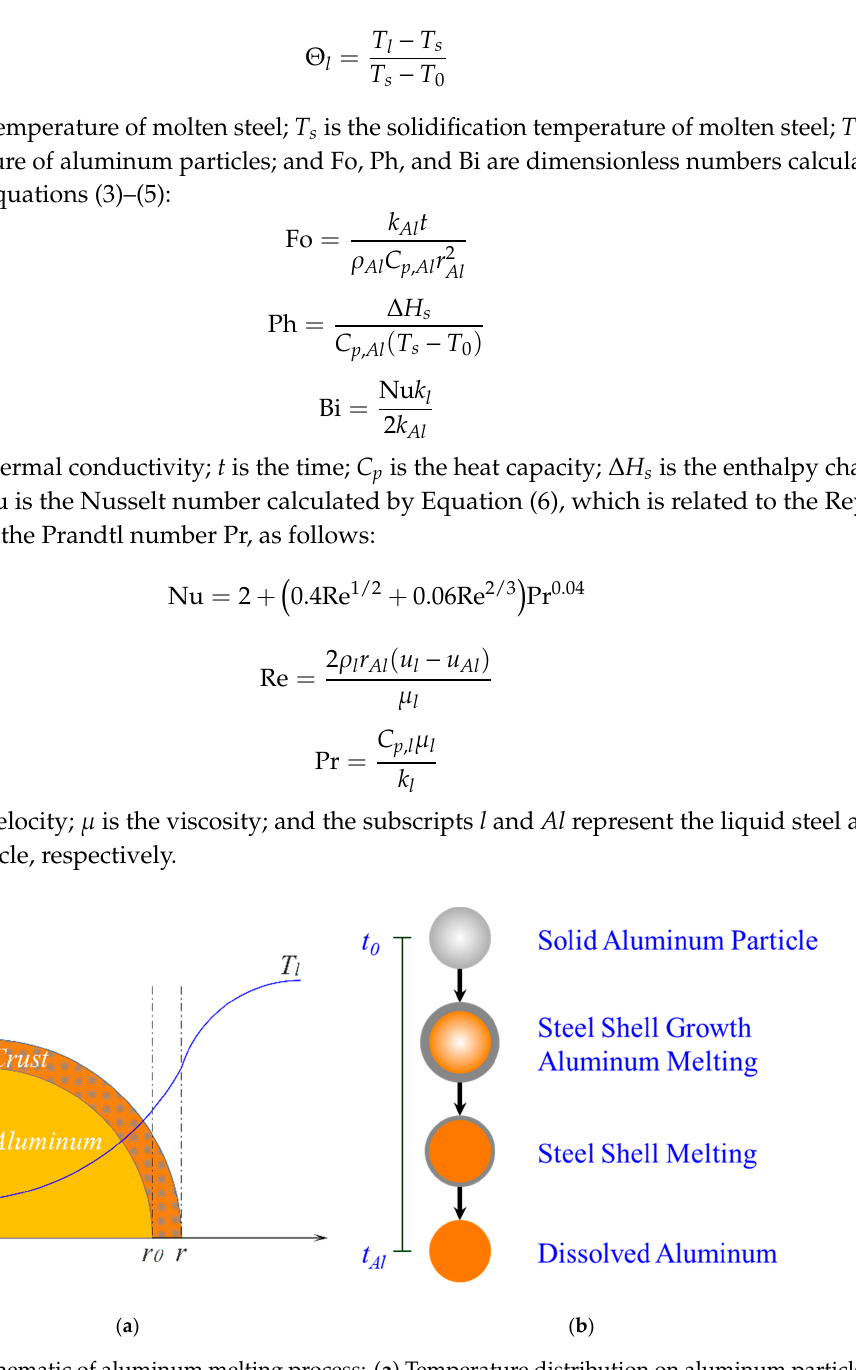
Figure 2. Schematic of aluminum melting process: ( a ) Temperature distribution on aluminum particles; ( b ) Aluminum particles’ melting process. ( T m is the temperature of aluminum particles). Table 1. Material properties and operation parameters (data from [24]). Further, the lifetime of the steel shell t Al is derived by Equations (3) and (5) from references [4,23] and given by Equation